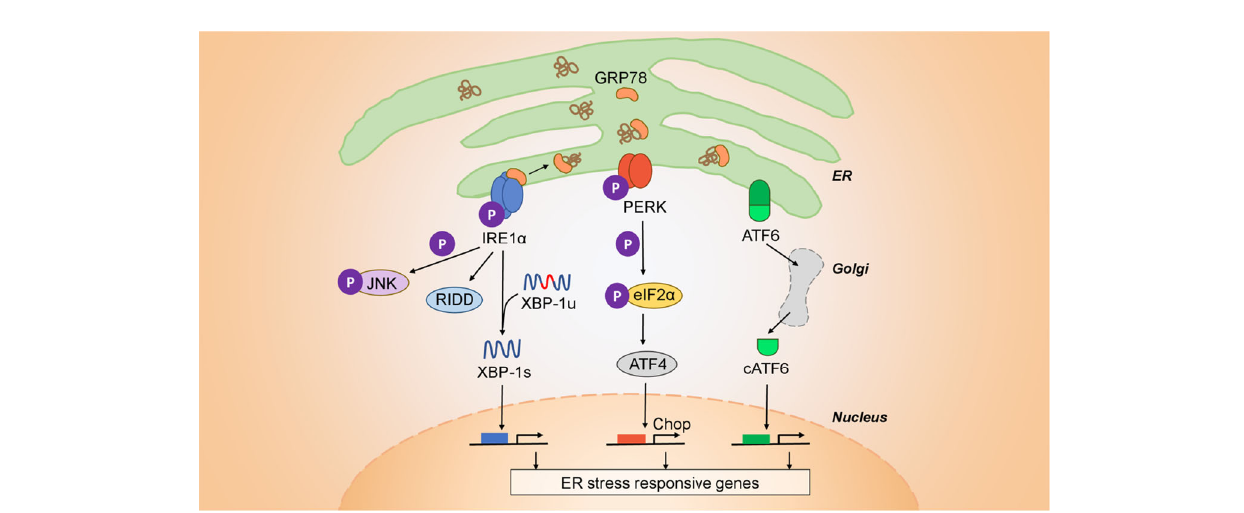
FIGURE 1 | Architecture of the UPR. The UPR is mediated by three initiator/sensor molecules: inositol-requiring enzyme 1 (IRE1 a ), PKR-like ER kinase (PERK), and activating transcription factor 6 (ATF6). These three initiator/sensor molecules are maintained in an inactive state through association with 78 kDa glucose-regulated protein (GRP78) (29). Upon ER stress induction, PERK phosphorylates the eukaryotic translation initiation factor 2 a (eIF2 a ) to control translation and further signal through downstream effectors such as the C/EBP homologous protein (CHOP) that modulates apoptosis. ATF6 translocates to the Golgi where it is cleaved into its functional form, and acts to restore ER homeostasis (32). IRE1 a is an endoribonuclease that upon activation initiates the unconventional splicing of the mRNA encoding X-box-binding protein 1 (XBP1). Spliced XBP1 (XBP1s) is a potent transcriptional activator that increases expression of a subset of UPR-related genes involved in ef fi cient protein folding, maturation, and degradation in the ER (30). IRE1 a also has a kinase function independent of its endonuclease activity through which it signals downstream through c-JUN and TRAF2. Finally, IRE1 a has an additional function that is independent of XBP1, is the endonucleolytic decay of many ER-localized mRNAs (regulated IRE1-dependent decay